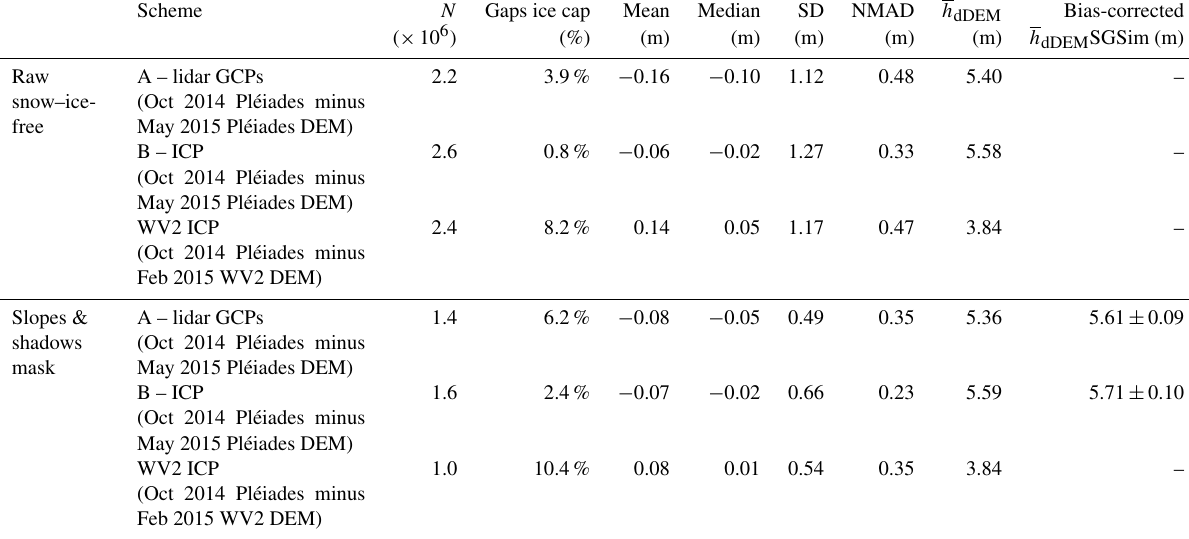
Table 2. Statistical analysis of the dDEMs in snow- and ice-free areas, and mean elevation difference on the ice cap, h dDEM . N repre- sents number of data points. The three bottom rows indicate the statistics after masking slopes > 20 ◦ and shadows. Bias-corrected SGSim represents the mean elevation bias from 1000 simulations and the standard deviation of the simulations (details in Magnússon et al., 2016a). Scheme N Gaps ice cap Mean Median SD NMAD h dDEM Bias-corrected ( × 10 6 ) (%) (m) (m) (m) (m) (m) h dDEM SGSim